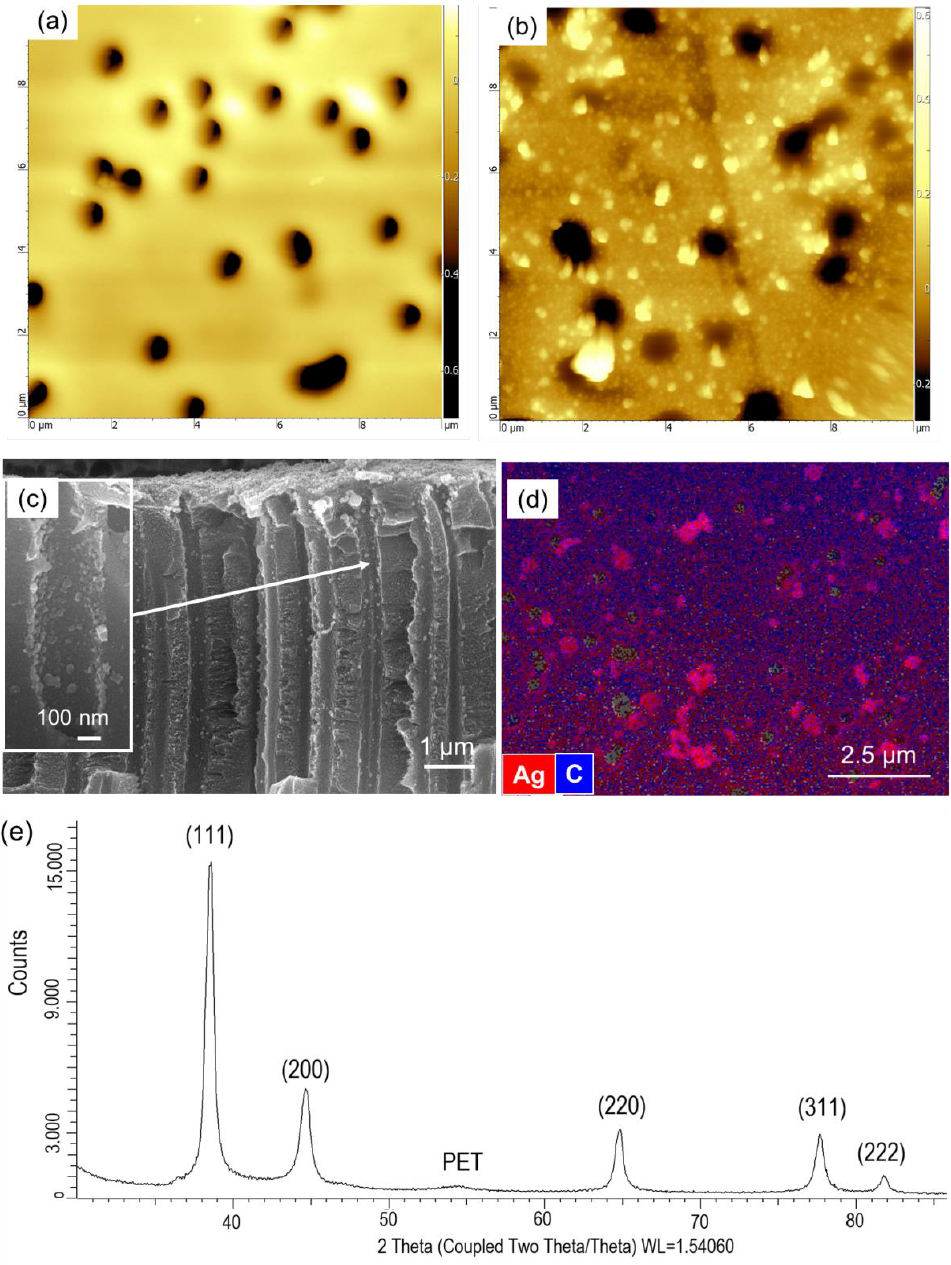
Figure 7. Atomic force microscopy (AFM) image of PDMAEMA- g -PET ( a ) and Ag@PDMAEMA- g -PET ( b ). The scanning area was 10 × 10 µ m 2 . Cross-sectional SEM image ( c ), SEM-EDX surface elemental mapping ( d ) and X-Ray diffraction (XRD) pattern of Ag loaded PDMAEMA- g -PET (Ag@PDMAEMA- g -PET) ( e ).